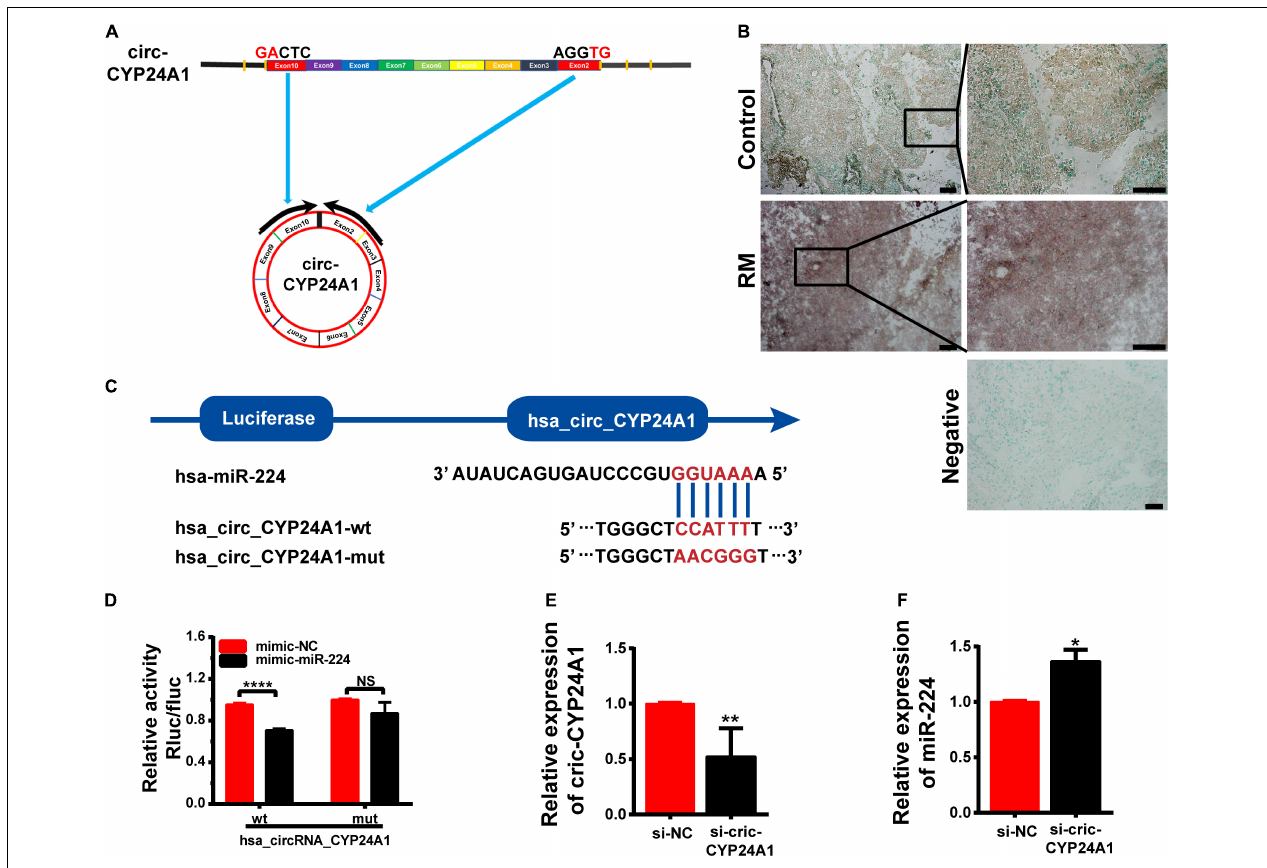
FIGURE 1 | Circ-CYP24A1 act as a sponge of miR-224. (A) Circ-CYP24A1 was derived from Exon 3 to Exon 10 of the human CYP24A1 gene. (B) In situ hybridization staining of circ-CYP24A1 in the decidua of patients with early RM and unintended pregnant women. Scale bar: 100 µ m. (C) Bioinformatics prediction of the binding site of miR-224 to circ-CYP24A1 and the wild and mutant sequences of circ-CYP24A1 luciferase plasmid. (D) Expression of luciferase activity. (E,F) Circ-CYP24A1 and miR-224 levels were detected using RT-PCR. RM, early recurrent miscarriage; control, unintended pregnant women; si-NC, negative control to siRNA (* p < 0.05, ** p < 0.01, **** p <